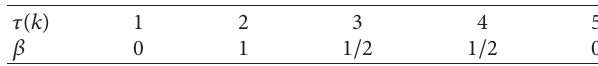
Table 1: For 𝜏(𝑘) = 1, 2, 3, 4, 5 , 𝛽